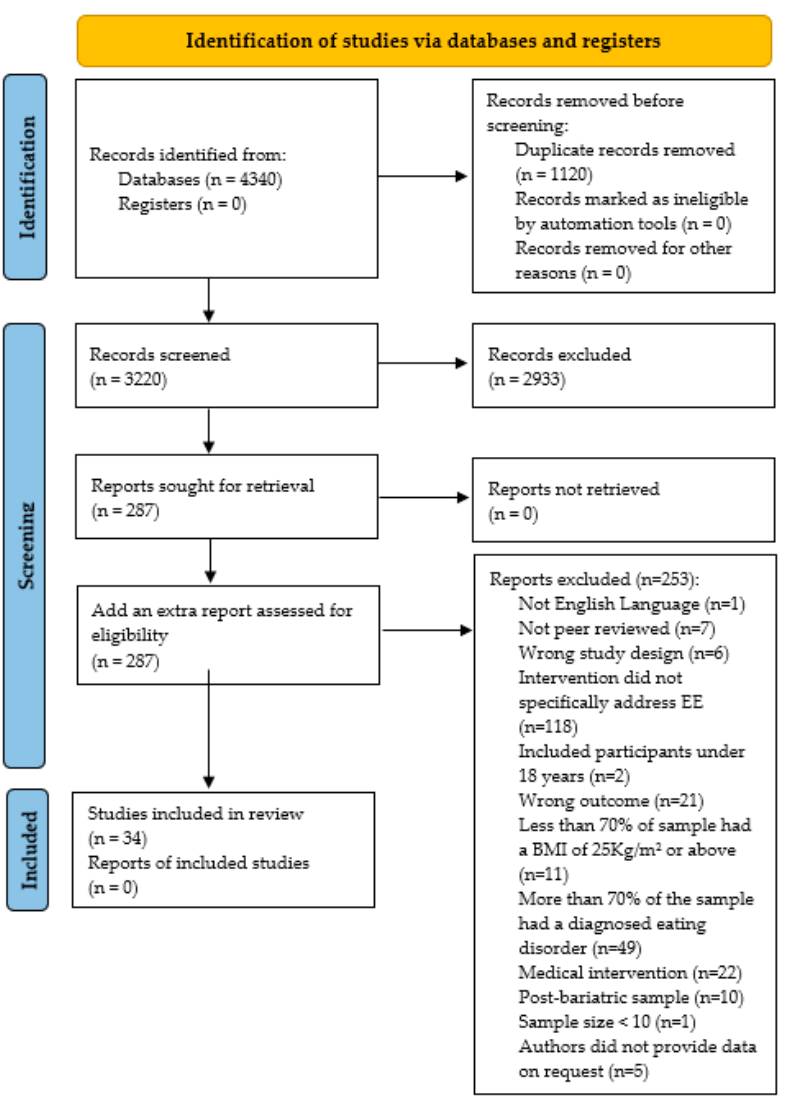
Figure 1. PRISMA flow diagram of search strategy for emotional eating interventions for adults living with overweight or obesity .